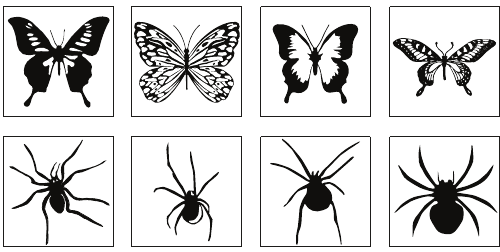
Figure 1: Example of the stimuli used in the